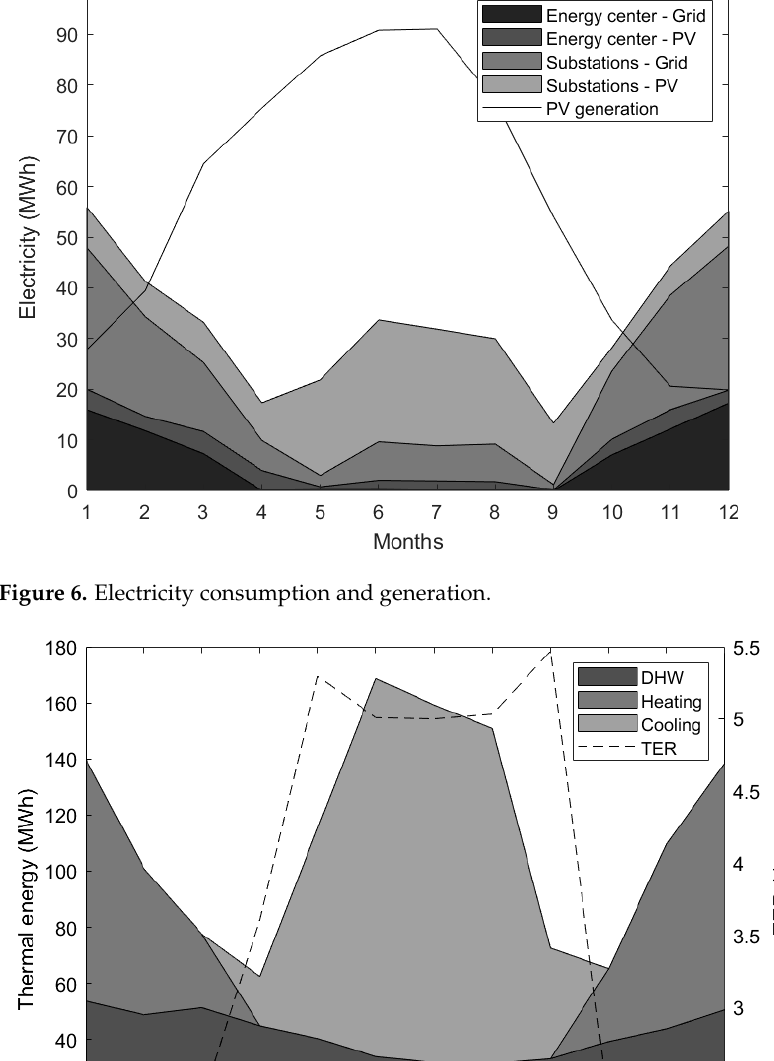
Figure 7. Thermal energy demand and